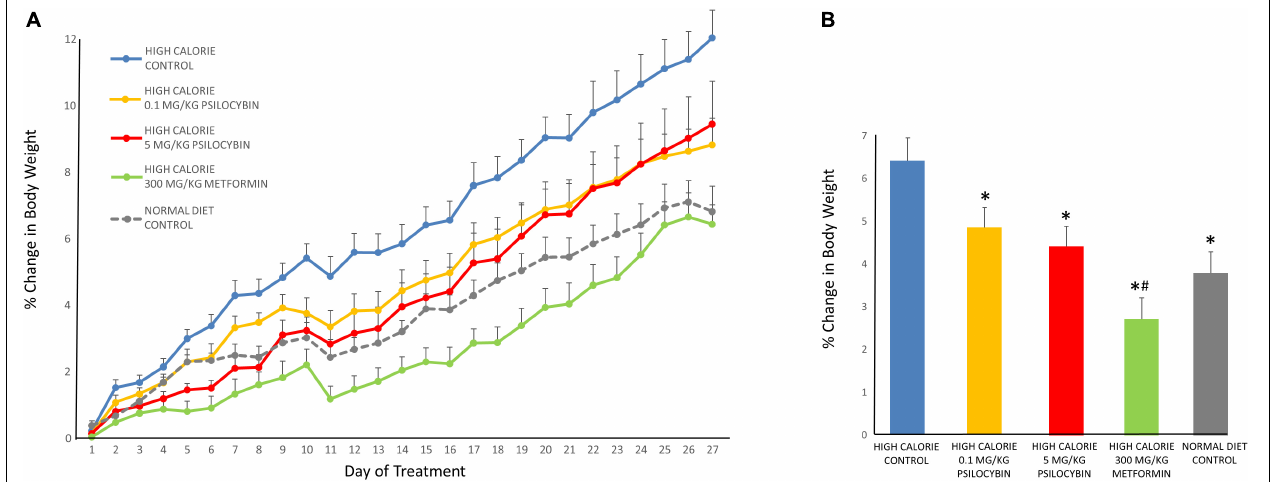
FIGURE 1 | Effects of chronic psilocybin or metformin on change in relative body weight. (A) Data demonstrate change in relative body weight on a daily basis after 27 weekday treatments in rats fed either a high calorie diet or regular rat chow. Values represent percentage change in body weight relative to body weight at baseline (i.e., the final day before drug treatment). Adult male rats ( n = 14–16 per group) were treated chronically with low (0.1 mg/kg i.p.) or high (5 mg/kg i.p.) doses of psilocybin, metformin (300 mg/kg p.o.) or vehicle (0.9% saline solution). Values are group means ± SEM. (B) Data represent mean change in relative body weight averaged across the 27 treatments. Values represent percentage change in body weight relative to body weight at baseline (i.e., the final day before drug treatment). Values are group means ± SEM. ∗ Statistically different from high calorie diet control group, p < 0.05; # Statistically different versus both psilocybin groups, p <